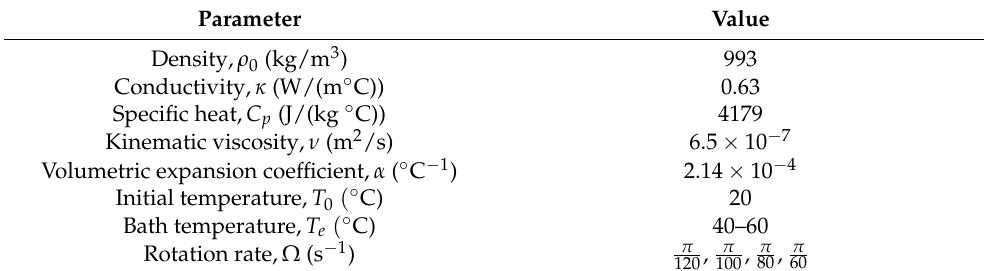
Table 1. Input parameters for water used for computations [33,34].